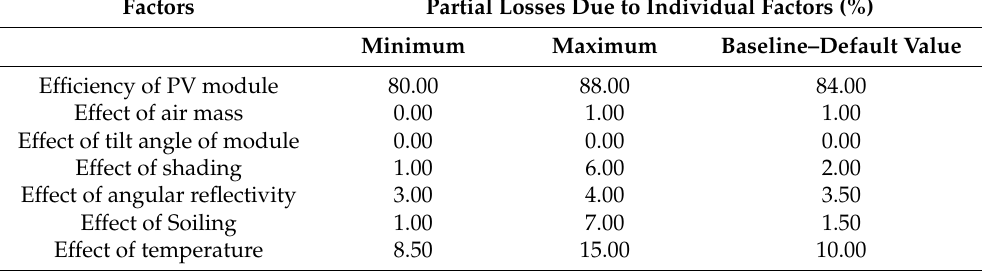
Table 2. Summary of the environmental derate factors and values considered in this prefeasibility assessment tool for the Caribbean SIDS.